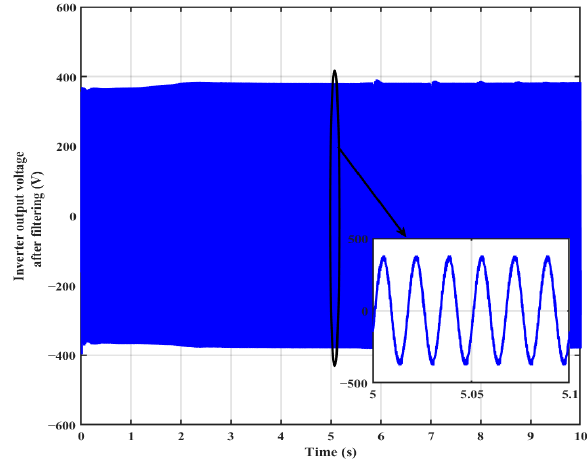
Figure 16. Voltage produced by the inverter after filtering.